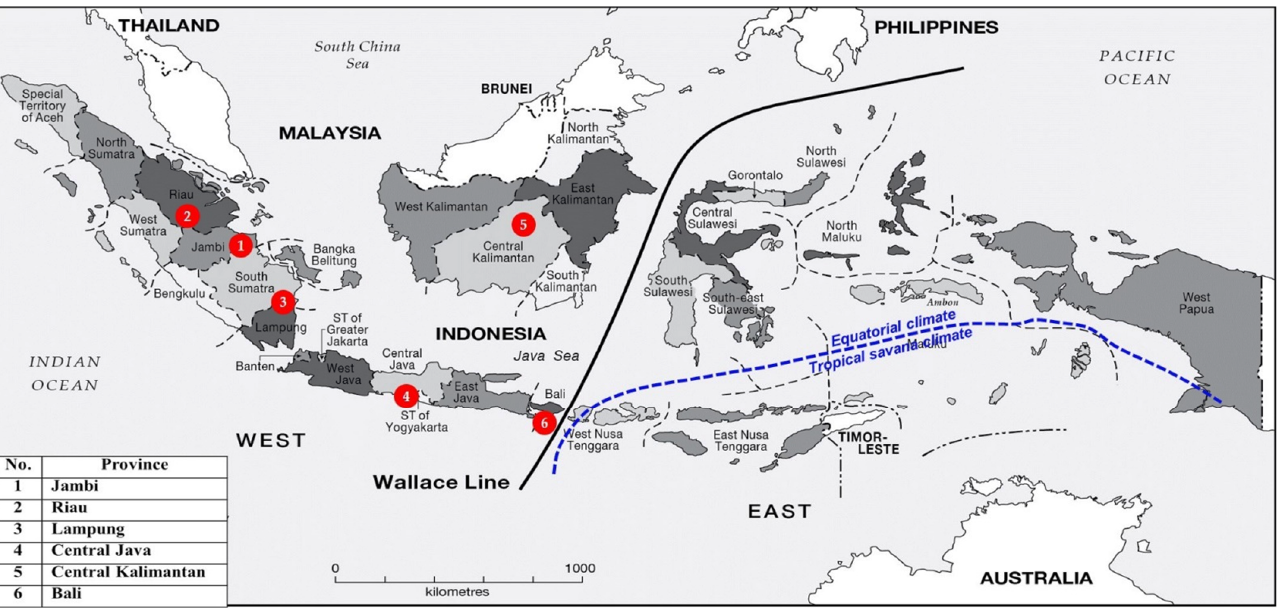
Figure 1. Map illustrating the six wet-climate provinces of western Indonesia designated as study